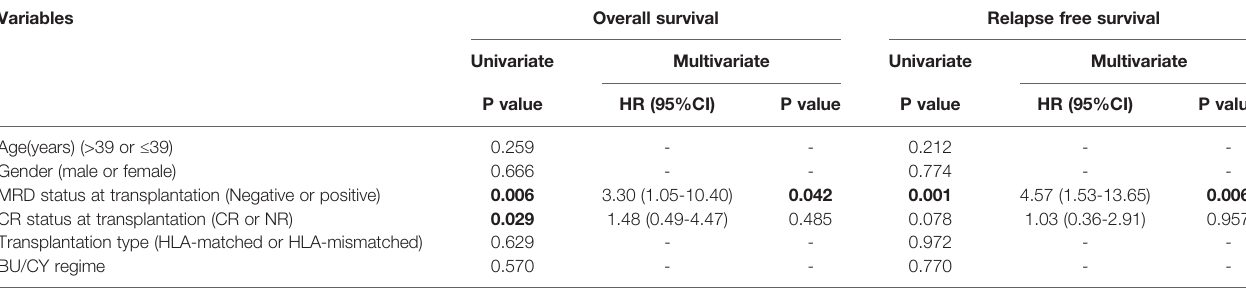
TABLE 3 | Univariate and multivariate analysis for OS and RFS in patients with transplantation. Variables Overall